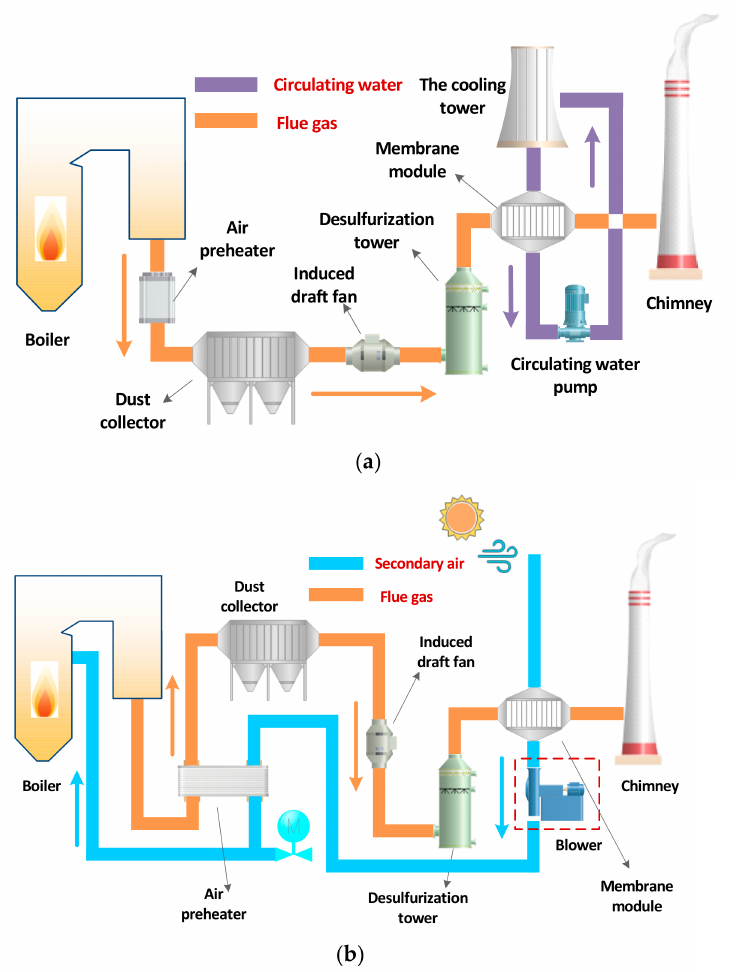
Figure 2. Application of ceramic membrane condenser in coal-fired power plant. ( a ) Circulation water cooling medium. ( b ) Secondary air cooling